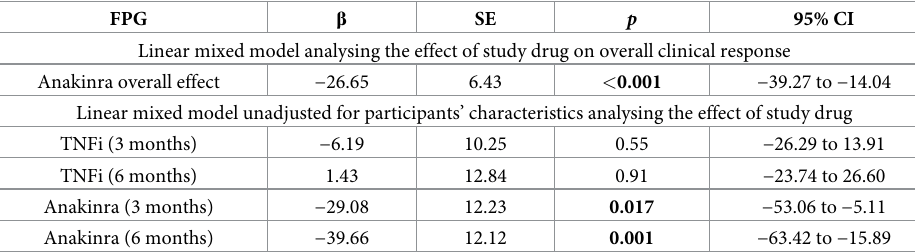
Analysing our results according to good EULAR response, a significant percentage of ana- kinra-treated participants reached a good EULAR clinical response when compared with shown in S7 Table. Assessing the effects of the study drugs on the reduction of DAS28 after 3 months by using a linear mixed model, there were significant effects of anakinra treatment ( β : 95% CI − 2.28 to − 1.22) on disease activity in both groups. The results after 6 months mirrored Table 3. Analysis of FPG as clinical response, linear mixed model analysing the effect of study drugs on FPG. FPG β SE p 95% CI Linear mixed model analysing the effect of study drug on overall clinical response Anakinra overall effect − 26.65 6.43 < 0.001 − 39.27 to − 14.04 Linear mixed model unadjusted for participants’ characteristics analysing the effect of study drug TNFi (3